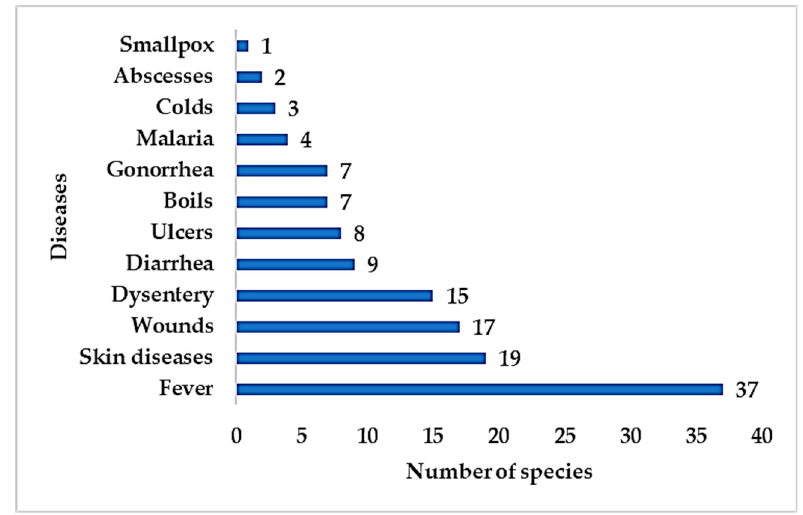
Figure 6. Number of epiphytic medicinal plant species used traditionally to treat infectious diseases.